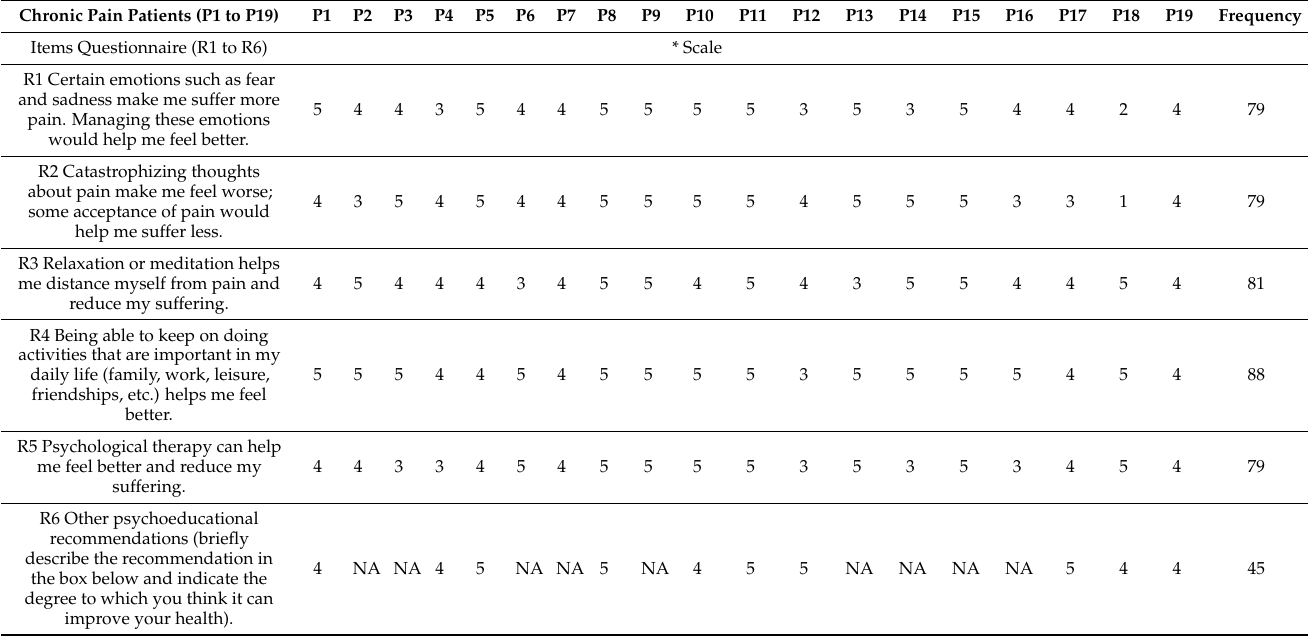
Table 4. Degree to which psychoeducational recommendations can improve